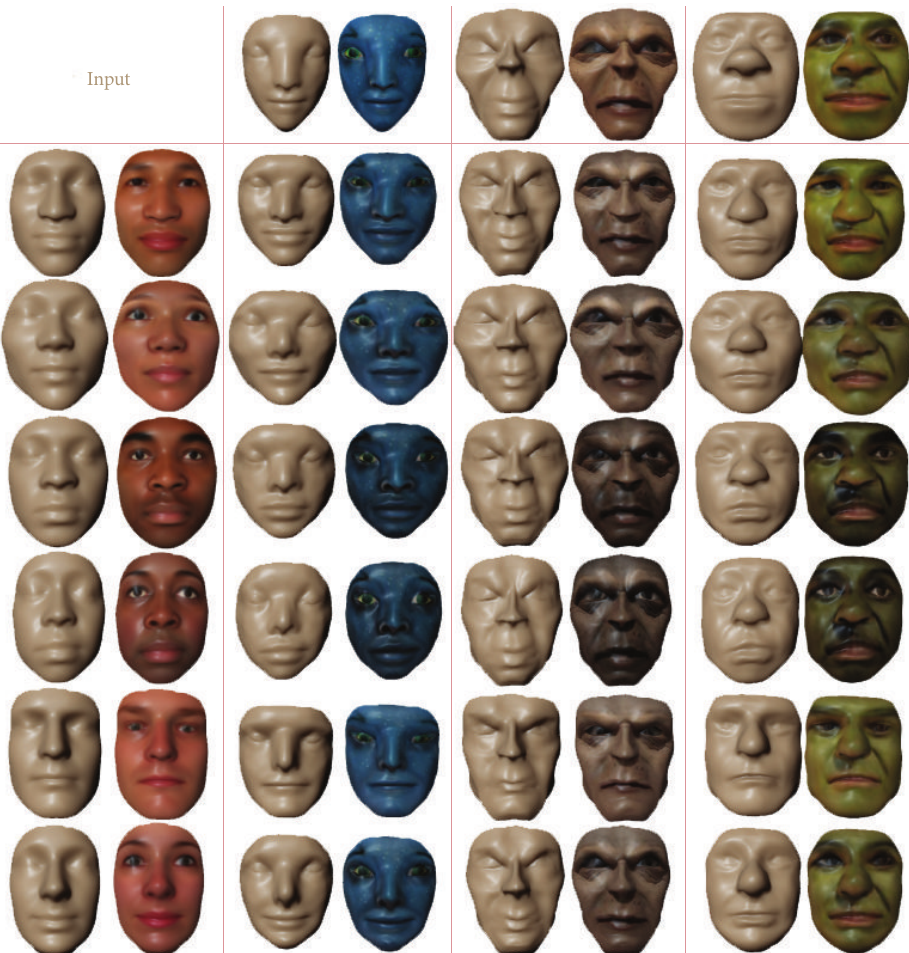
Figure 9: Example results by our approach. The leftmost column shows the input HI-faces. The top row shows the input AS-faces.